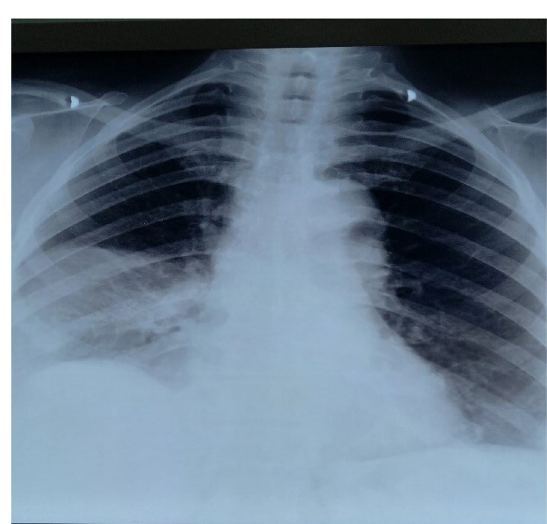
Fig. 1 Chest X-ray showing homogeneous opacity on the right middle and lower lung zones and elevated right